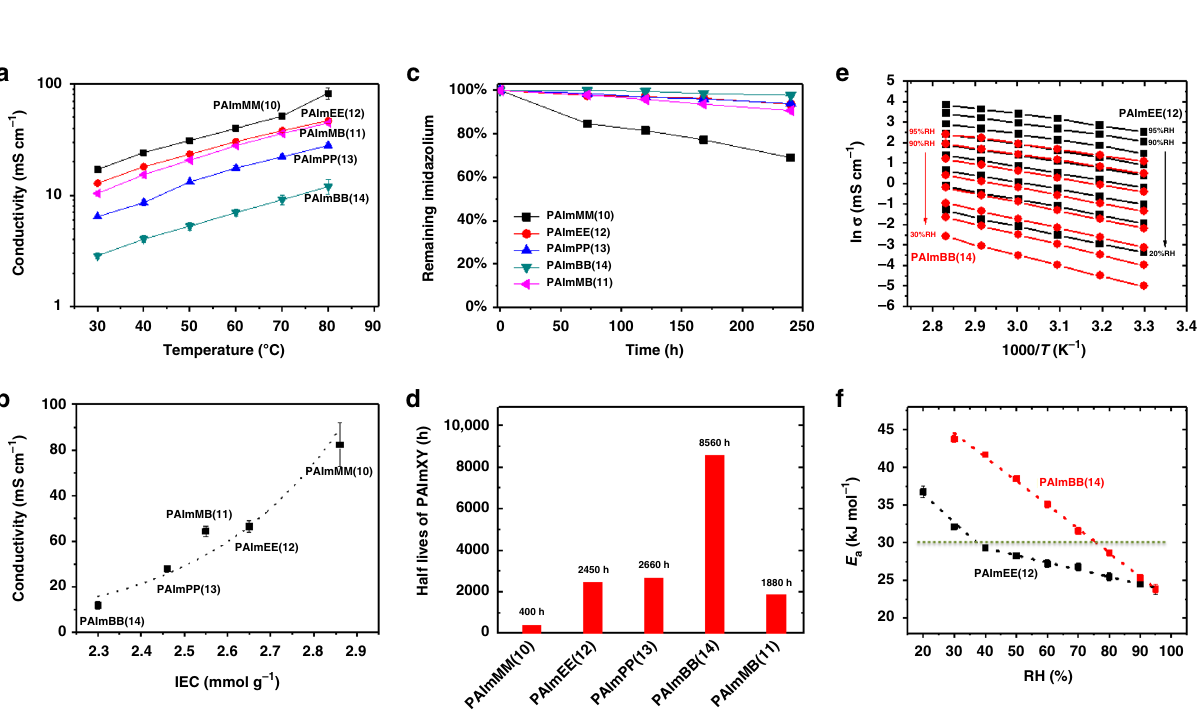
Fig. 5 Properties of PAImXY(#). a Ionic conductivity of PAImXY( # ) (Cl − ). Temperature-dependent conductivity under 95% RH. b Ionic conductivity at 80 °C, 95 % RH vs. IEC of PAImXY( # ). c Stability of PAImXY( # ) to caustic solution after immersion in 10 M KOH at 80 °C for 240 h. d Calculated half-life. e Arrhenius plots of ion conductivity of PAImEE( 12 ) (black) and PAImBB( 14 ) (red) in chloride form at various temperature and RH in air. f The corresponding calculated activation energy at a given morphology induced by changing the N-alkyl group. X-ray ( 12 )Cl − and PAImBB( 14 )Cl − , measured at various temperatures scattering of the iodide form of PAImMM( 10 ) under vacuum and humidities, follows an Arrhenius-type behavior shown in (Fig. 6a, yellow) yields a complex scattering pattern: four distinct Fig. 5e. Both PAImEE( 12 ) and PAImBB( 14 ) possess a similar E a peaks are located at ~4, 8, 16, and 20 nm ─ 1 . Only the 16 nm − 1 of 24 kJ mol − 1 at 95% RH (Fig. 5f). The E a of PAImBB( 14) is peak changes position signi fi cantly for polymer analogs bearing longer N-alkyl groups, although the 4 and 20 nm − 1 peaks weaken in intensity. Only the 8 and 16 nm − 1 peaks are clearly visible in the scattering pro fi le for PAImBB( 14 ) (Fig. 6a, b, red). The 4 nm − 1 and 8 nm − 1 peaks correspond to Bragg lengths of ~1.6 and 0.8 nm. As DFT results reveal that the monomer length is 1.6 nm, we interpret these peaks as being the monomer – monomer and anion – anion spacings along the polymer backbone. The 16 nm − 1 peak corresponds to a Bragg length of ~0.4 nm and is assigned to the distance between the anion and the cationic imidazolium unit. The 16 nm ─ 1 peaks shift to higher scattering wavevector (Fig. 6b) as the N-alkyl group is lengthened from methyl to butyl, which implies the distance between anion and imidazolium is decreas-